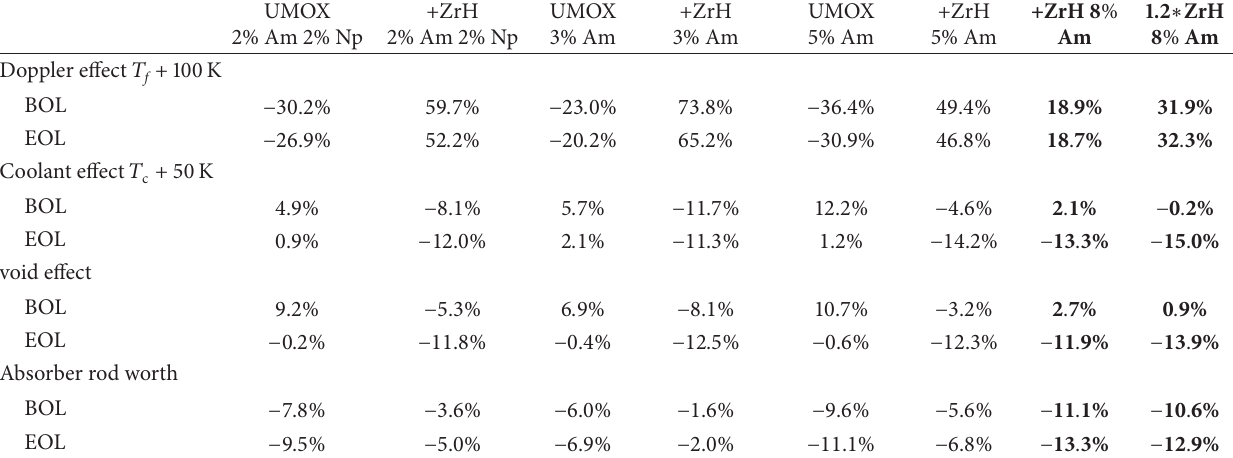
Table 3: Feedback effects and absorber worth for the cases with different transmutation